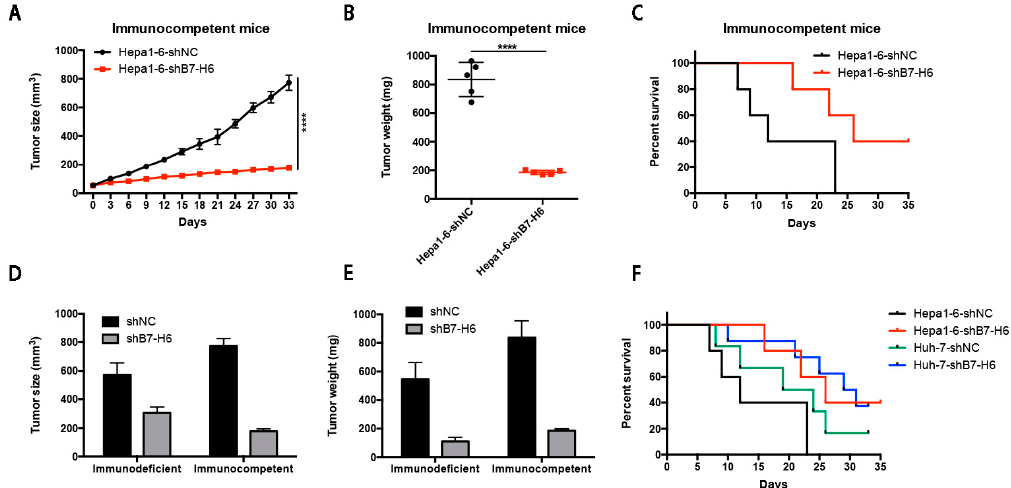
Figure 8. B7-H6 suppresses tumor progression and is associated with tumor immunity. ( A , B ) Hepa1-6-shB7-H6 and Hepa1-6-shNC were subcutaneously injected into the left flank of the C57BL/6 mice. Tumor size ( A ) and weight ( B ) of two groups are shown. **** p < 0.0001, Student’s t -test. ( C ) Survival rates of two subcutaneous groups are shown. ( D , E ) Tumor size and weight of subcutaneous tumors in immunocompetent and immunodeficient mice are shown. ( F ) Survival rates of four subcutaneous groups are shown.